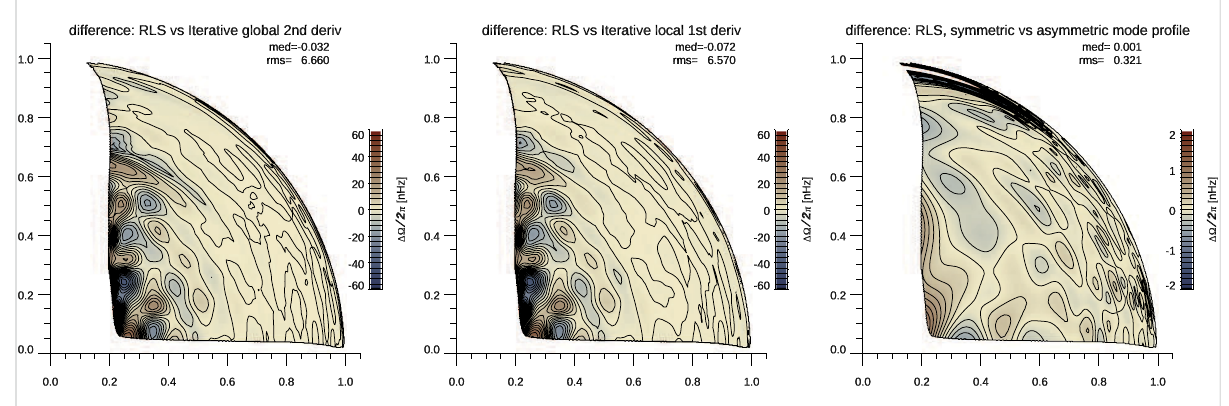
FIGURE 15 Differences in inverted rotation pro fi les when using different methodologies but the same splittings or the same method and splitting resulting from fi ttingsymmetricorasymmetricmodepro fi les.Fromlefttoright:RLS vs .iterativeglobalsecond-derivativeinversionmethod,RLS vs .local fi rst- derivative inversion method, and the RLS method but splitting resulting from symmetric or asymmetric fi